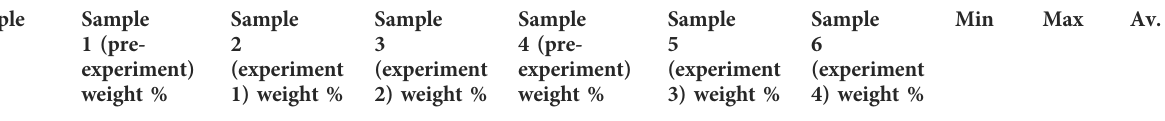
TABLE 2 Results of the EDS mineral maps analyses showing sediments compositions before and after hydrothermal reactor experiments for the samples from Stations 028A and